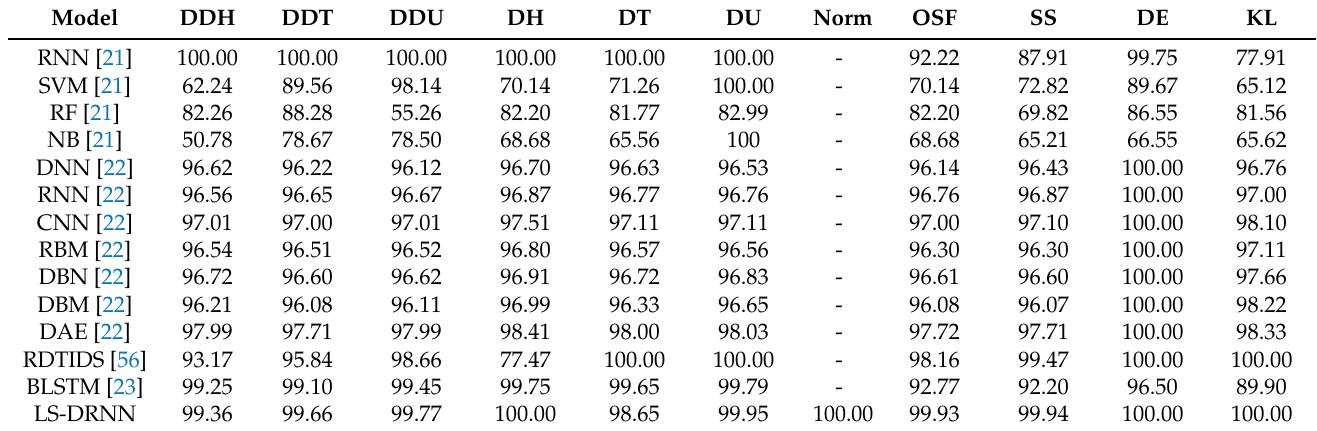
Table 8. Recall of ML and DL models across 11 classes.